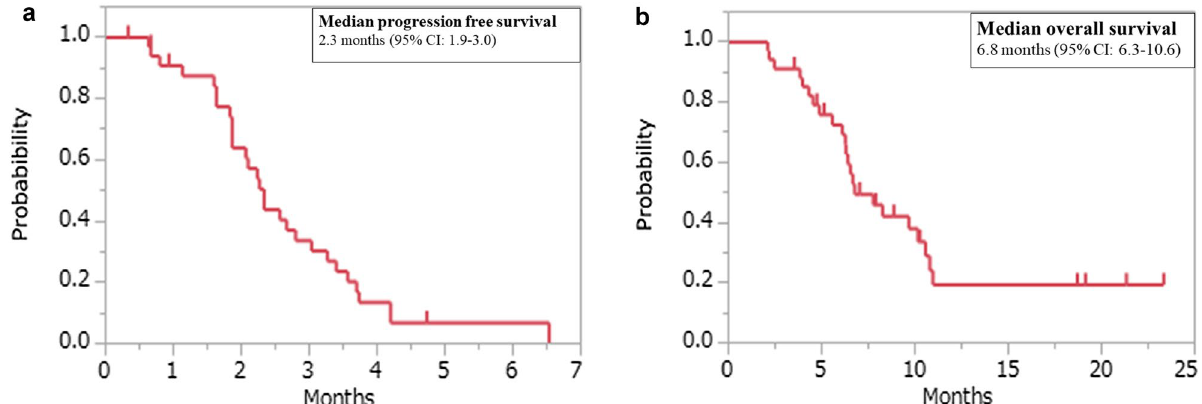
Figure 1. Kaplan–Meier plots of ( a ) progression-free survival (PFS) and ( b ) overall survival (OS) among the study